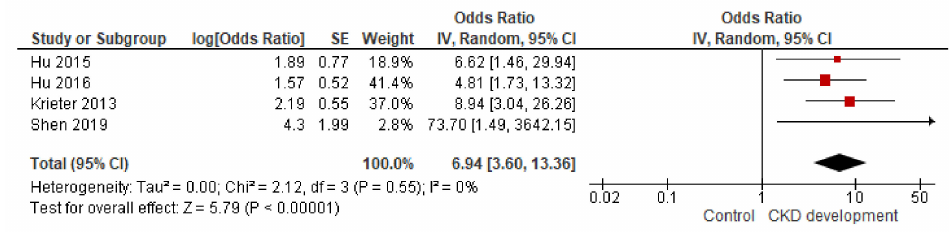
Figure 5. Analysis of the inverse variance of the four publications that study BPA in blood and kidney disease